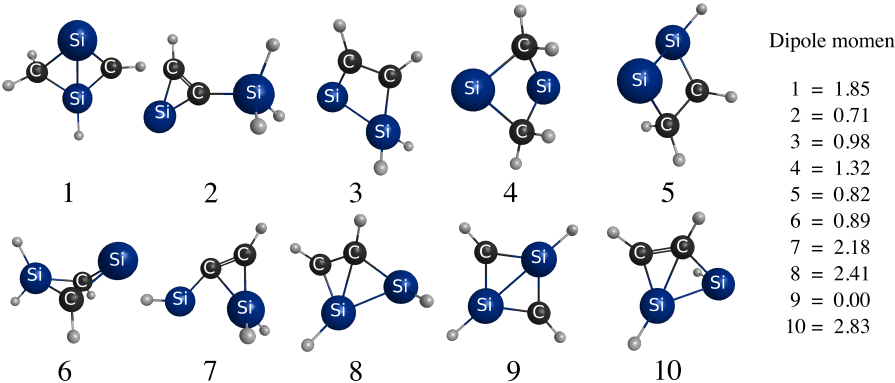
Figure 1. Low-lying C 2 Si 2 H 4 isomers optimized with B3LYP/Def2-QZVP and B2-PLYP/Def2-QZVP- level dipole moments.